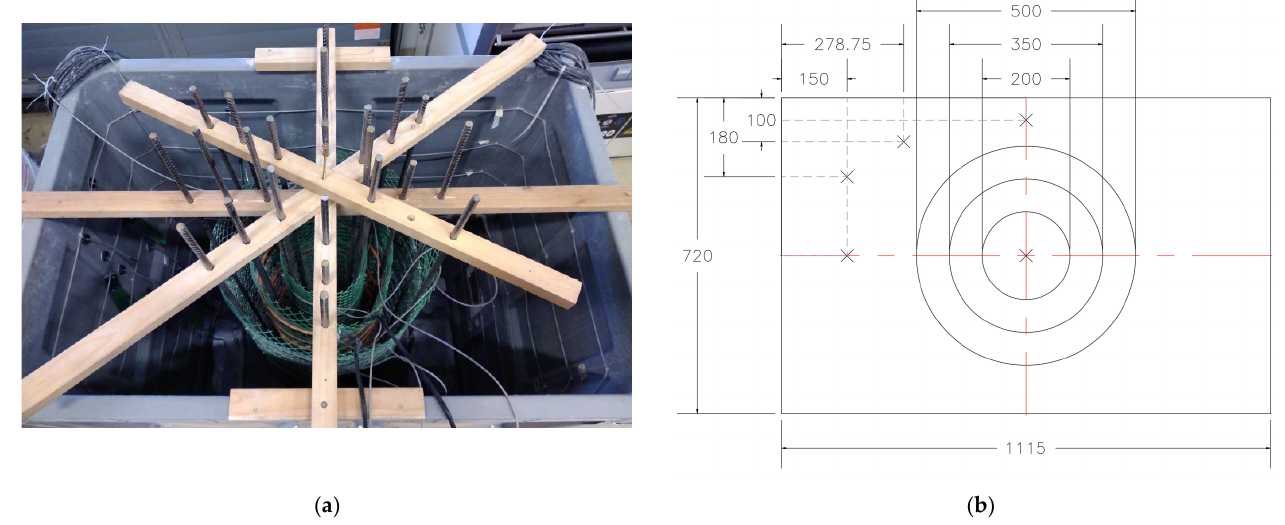
Figure 5. Experimental setup top view ( a ) and all dimensions and positions of sensors ( b ) in mm.